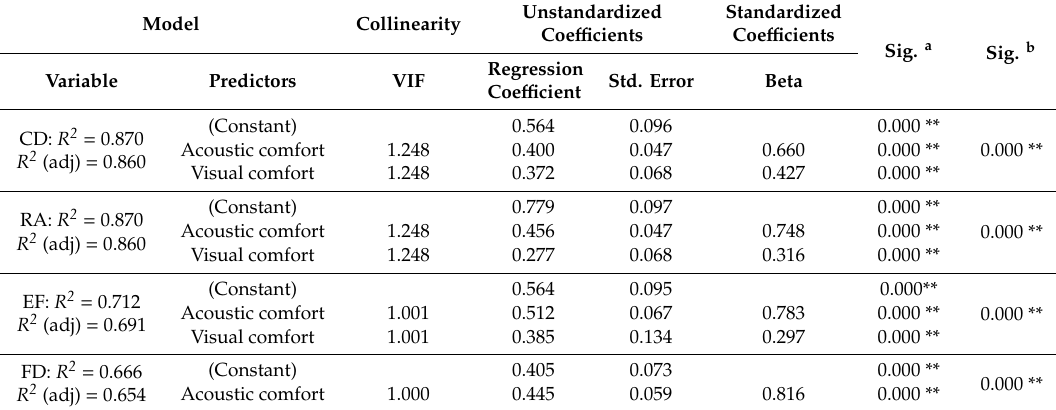
Table 3. The stepwise regression model for audio-visual experiences and psychological responses in Cloves Park. Model